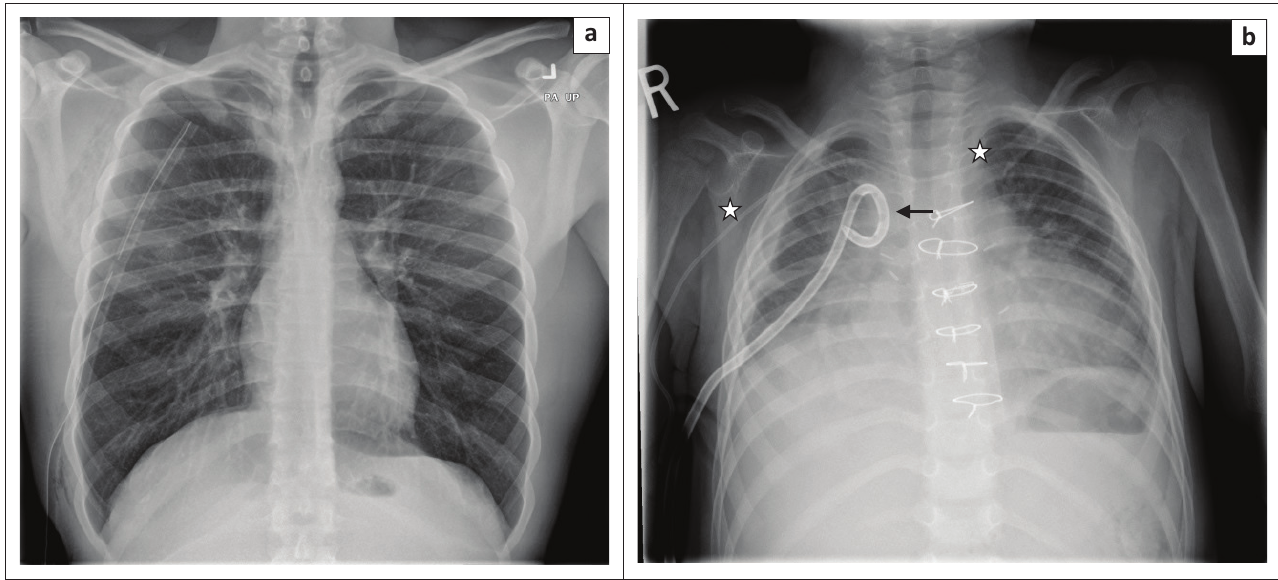
FIGURE 4: (a) Chest radiograph showing an intercostal drainage (ICD) tube introduced for pneumothorax; (b) a pigtail catheter (arrow) in the right thorax inserted for pleural effusion. Additionally, a malpositioned right peripherally inserted central venous catheter (PICC) [star] is noted with its tip in the left brachiocephalic vein.